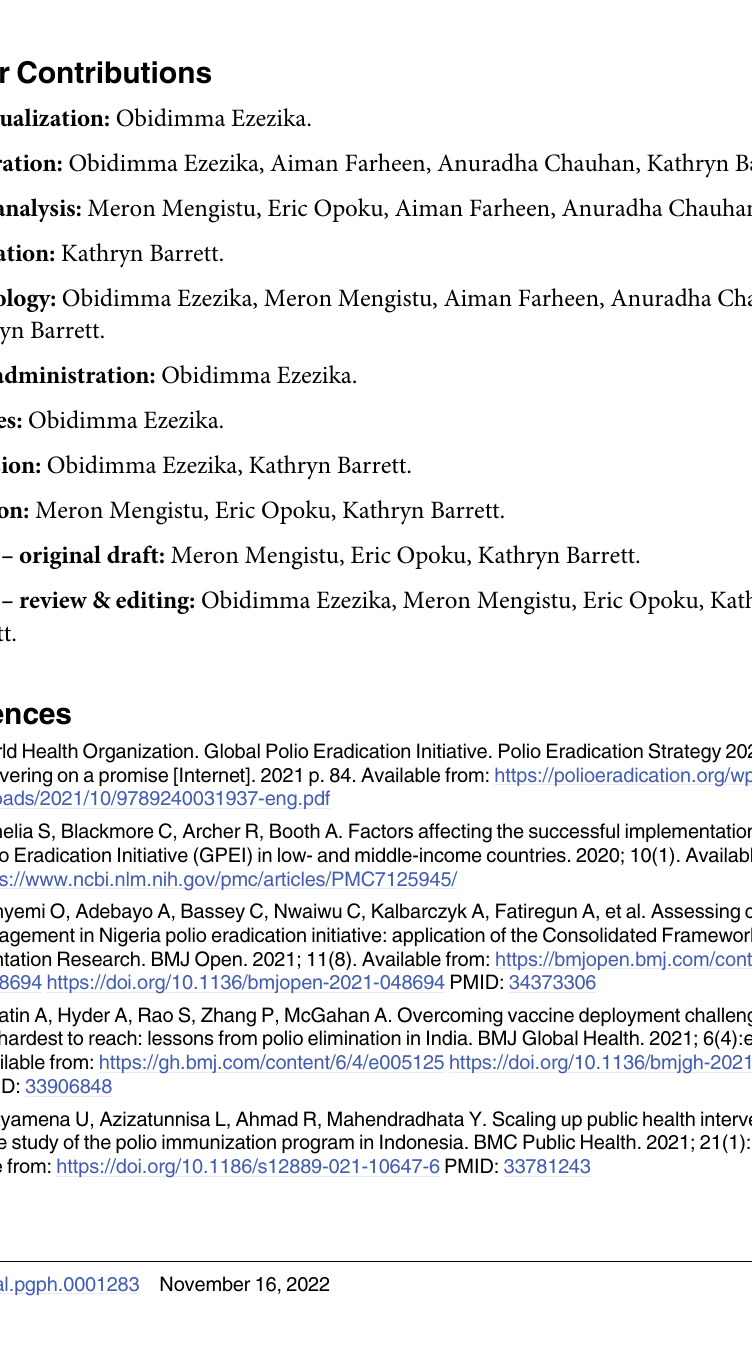
S1 Table. Barriers to polio vaccination and eradication programs. S2 Table. Facilitators to polio vaccination and eradication programs. S3 Table. Study